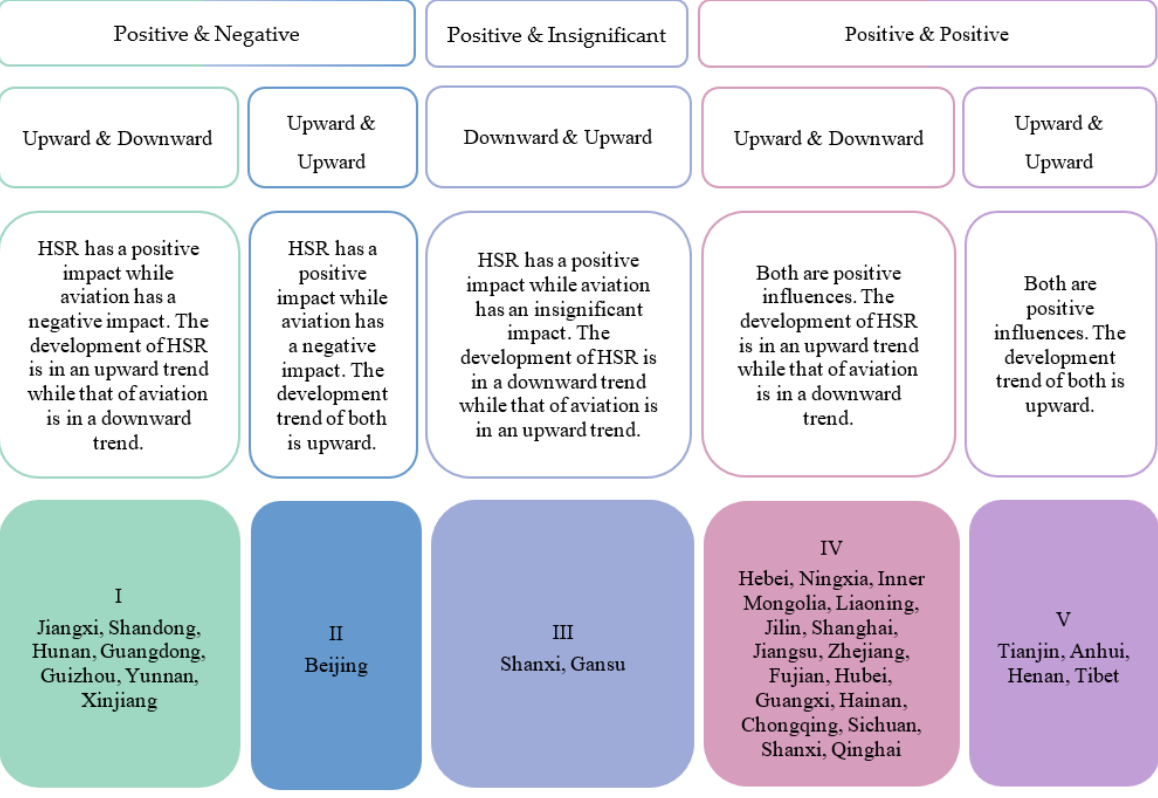
Figure 4. Characteristics and types of different provinces. Note: This figure was drawn using Word and is based on the analysis results in Sections 3.3.1 and 3.3.2.